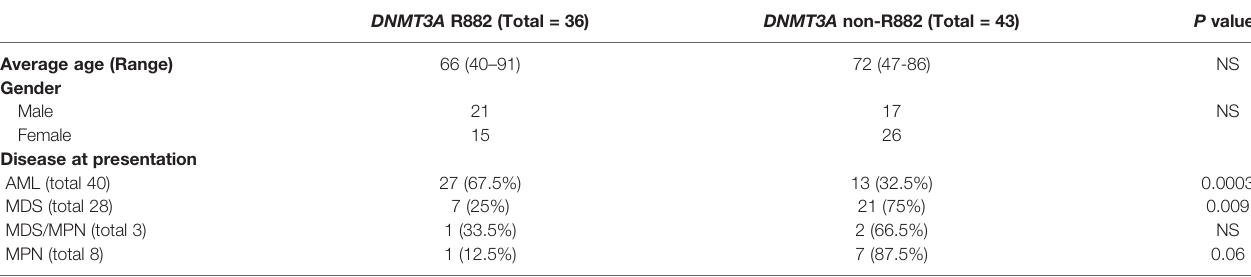
TABLE 1 | Demographics and disease presentation of myeloid neoplasms with DNMT3A (R882 vs. Non-R882)